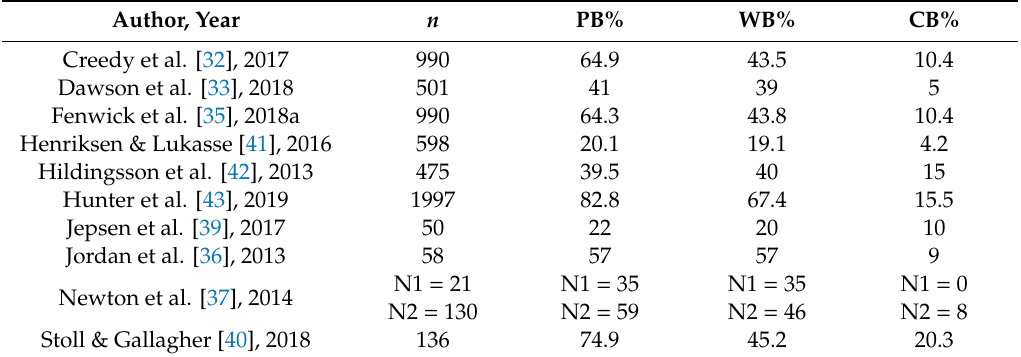
Table 3. Prevalence of personal, work, and client related burnout (CBI scores > 50 points).